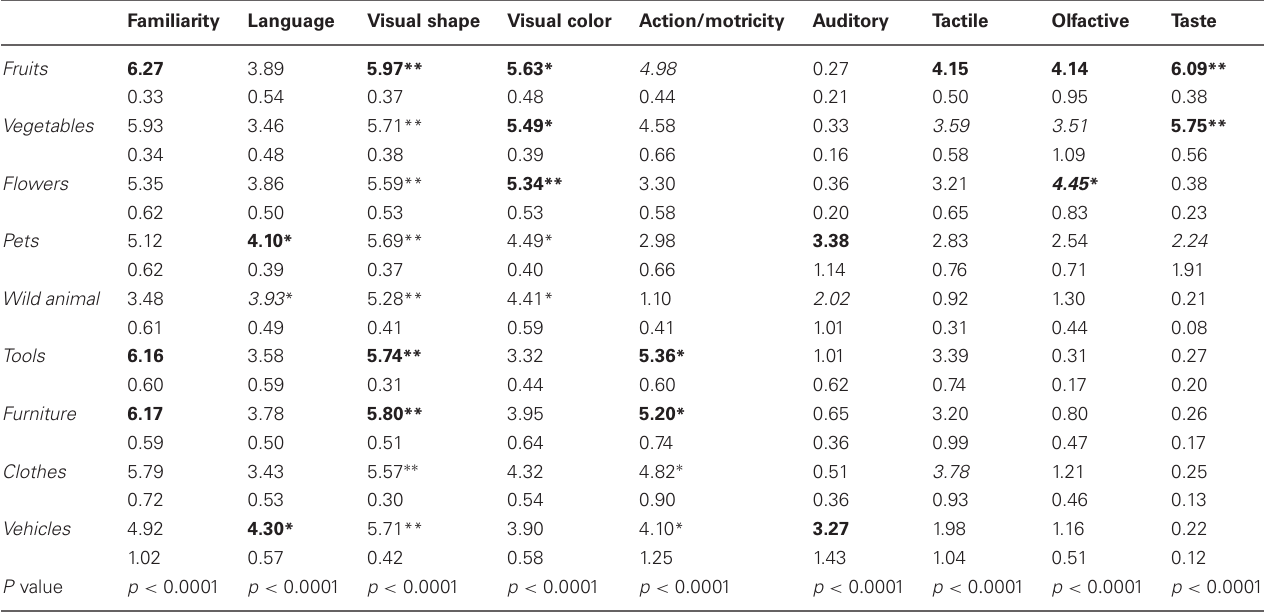
Table 3 | Overall mean values of familiarity and judgments of relevance of the various sources of knowledge for specific semantic categories of animals, plant life, and